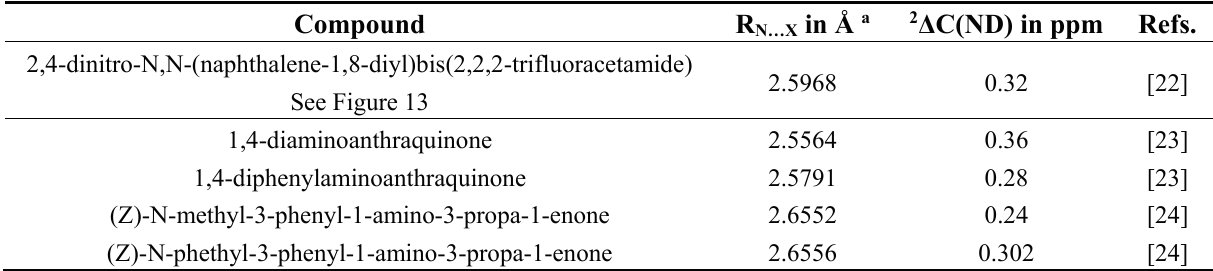
Table 1. Calculated heavy atom distances and two-bond deuterium isotope effects on 13 C chemical shifts.